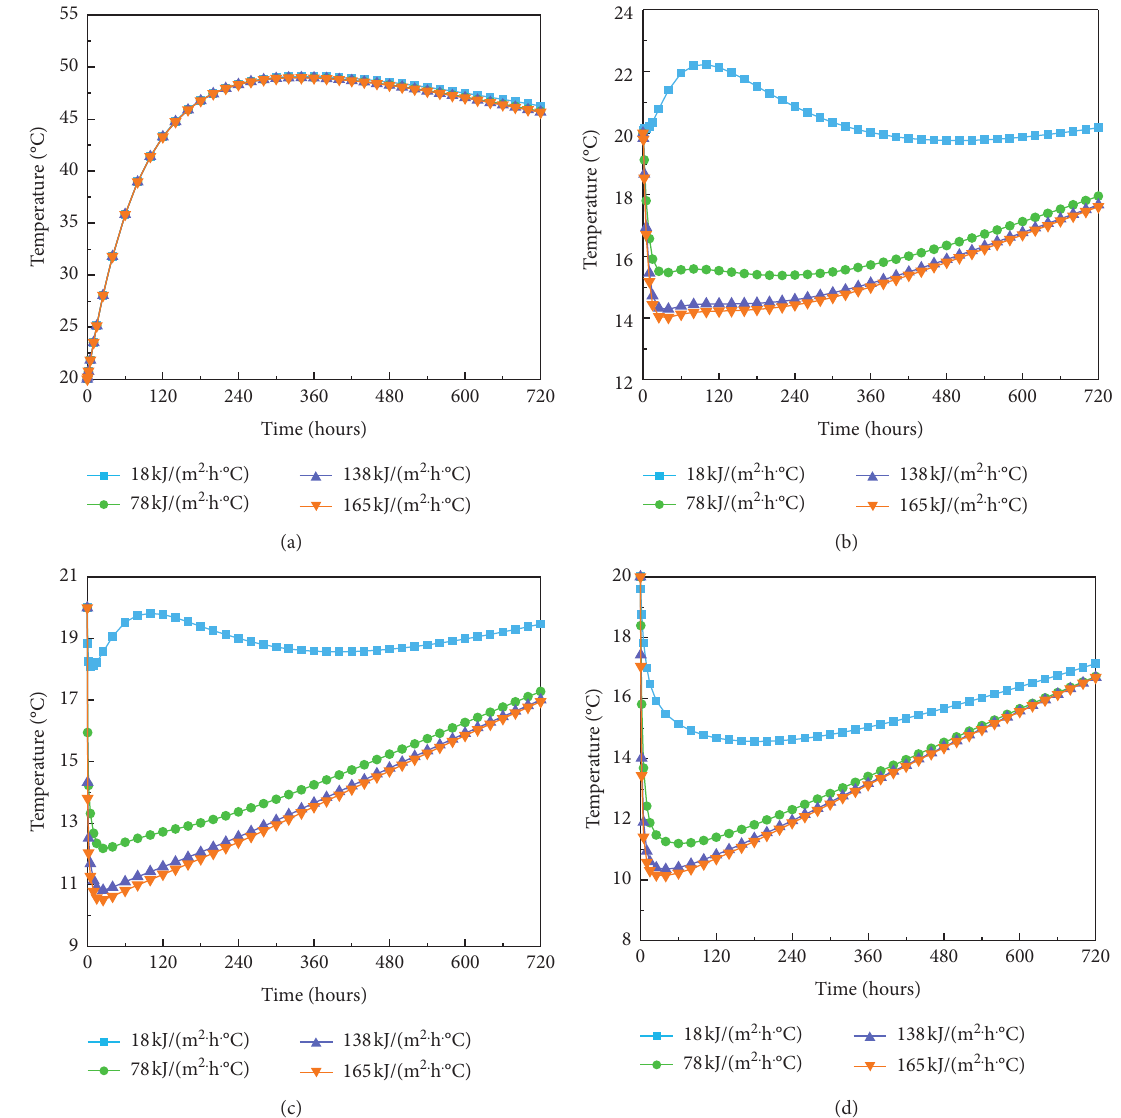
Figure 8: Temperature-time curves with different surface heat diffusion coefficients. (a) Point A, (b) point B, (c) point C, and (d) point